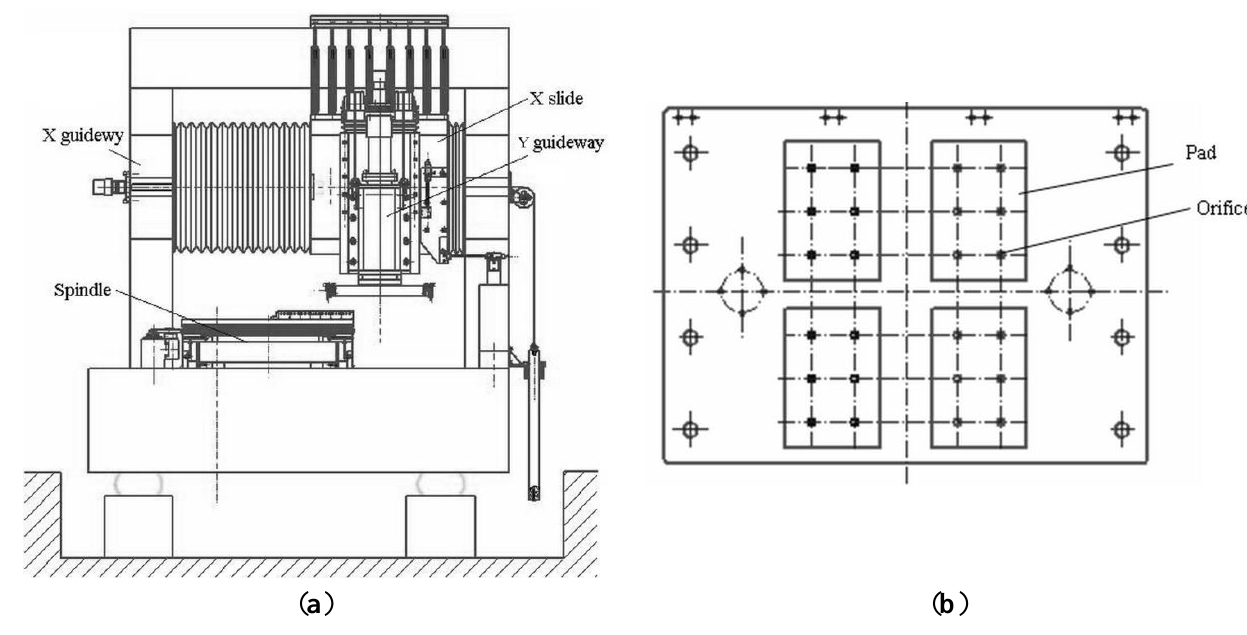
Figure 1. ( a ) Configuration of the guideway; ( b ) Structure of the aerostatic